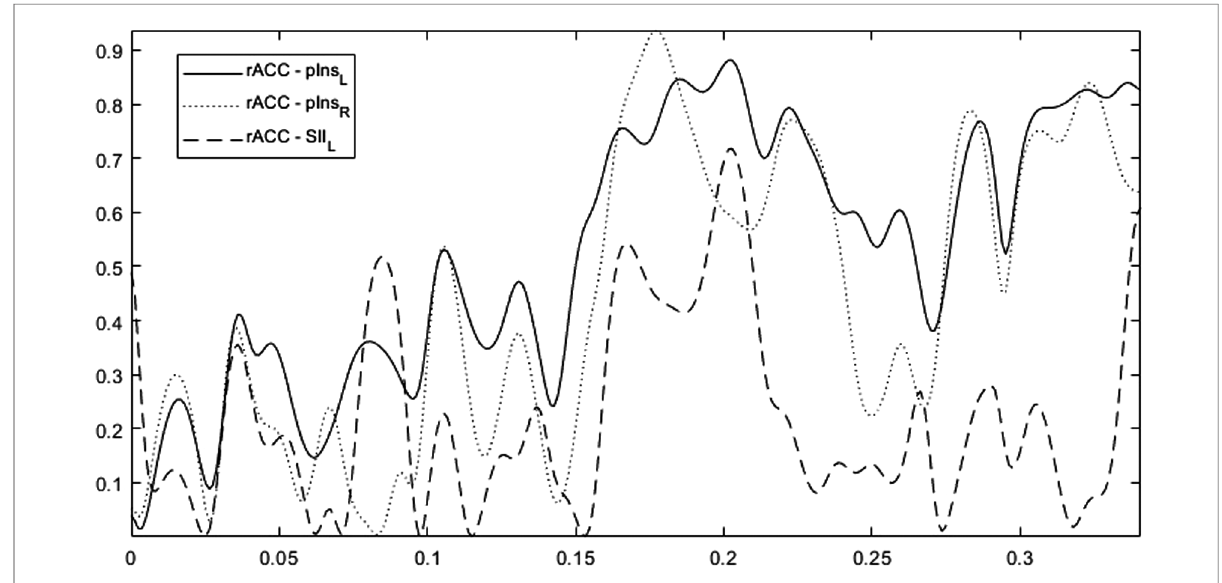
FIGURE 4 The trends of coherence versus frequency for the rACC paired with the ROIs pInsL, pInsR, SIIL for a representative learner (subject-4). The overall frequency range is [0.0012 – 0.33] Hz with a frequency step of 0.0012